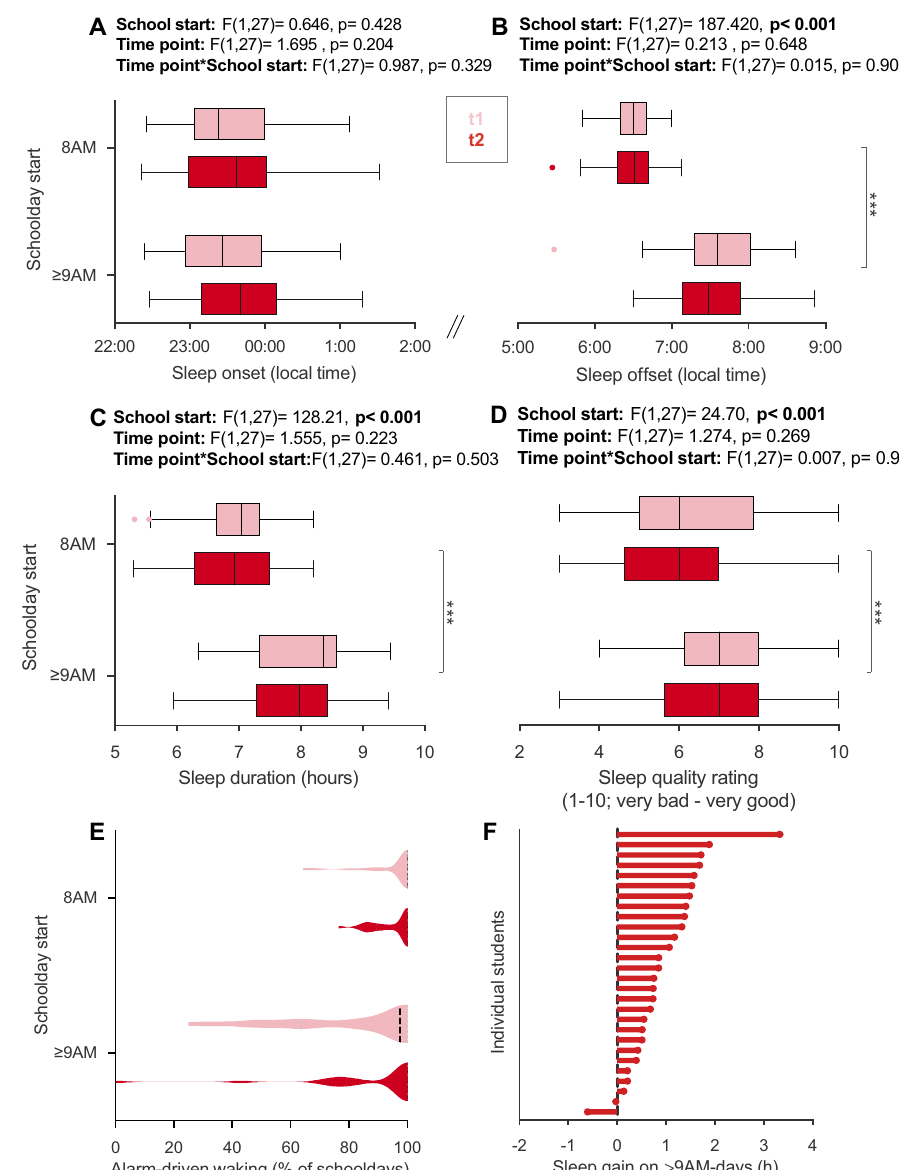
Figure 2. Comparison of sleep parameters between 8AM-days and ≥ 9AM-days in the flexible system. ( A – F ) Sleep parameters from the longitudinal cohort (n = 28) comparing 8AM and ≥ 9AM-days at t1 (light red) and t2 (dark red) intra-individually. ( A ) Average sleep onset, ( B ) offset, ( C ) duration, and ( D ) quality on 8AM versus ≥ 9AM-days in the flexible system across time points. Results of two-way repeated measures ANOVA with the within-subject factors school start (8AM/ ≥ 9AM) and time point (t1/t2) are reported above each graph. Brackets indicate statistically significant post-hoc comparisons. ( E ) Proportion of schooldays with alarm-driven waking. ( F ) Sleep gain on ≥ 9AM-days at t2 for each student. Depicted is the absolute difference in average sleep duration between 8AM and ≥ 9AM-days. Positive values mean longer sleep on ≥ 9AM-days. Dashed lines in violin plots show medians. All boxplots are Tukey boxplots. *p < 0.05, **p < 0.01, ***p <